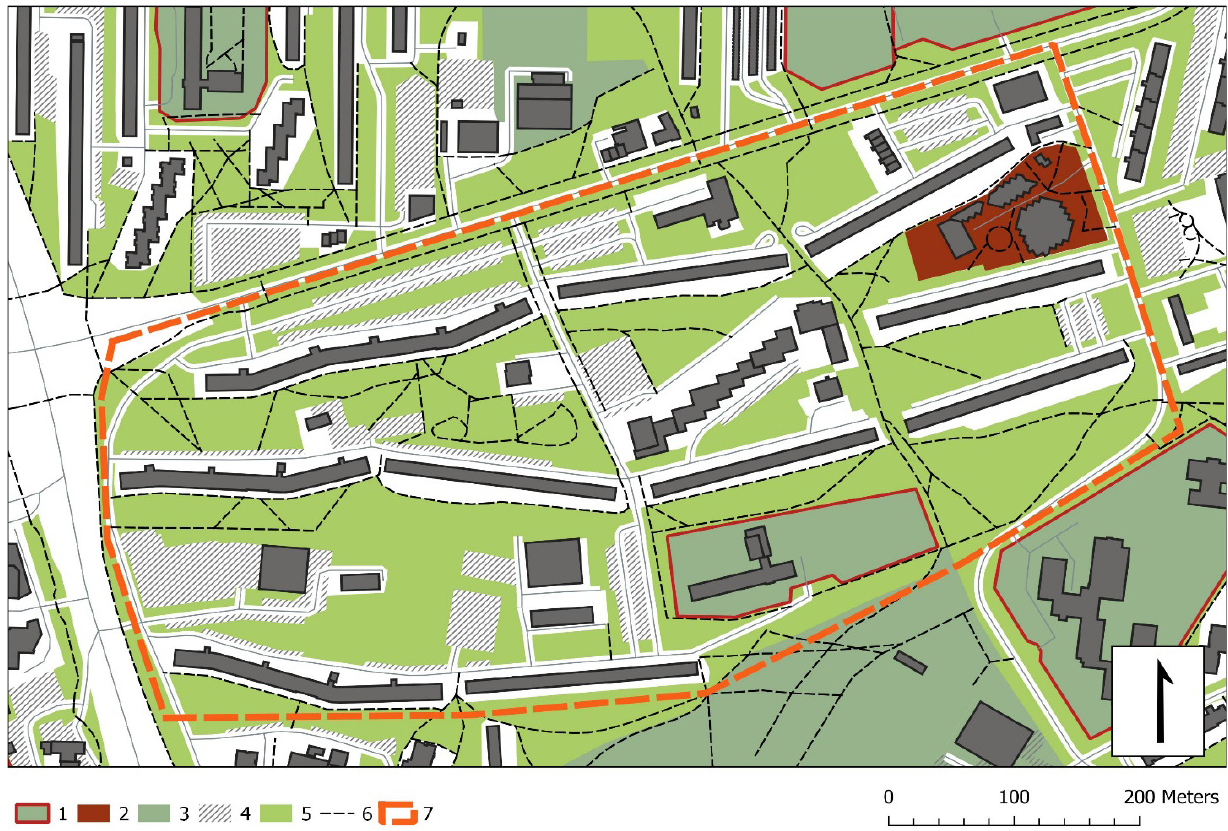
Figure 3. Analysed area of the Przymorze Wielkie housing estate in Gdansk with a schematic representation of green areas. Notes: (1) greenery isolating and accompanying buildings; (2) retail and recreational spaces; (3) fenced public facilities